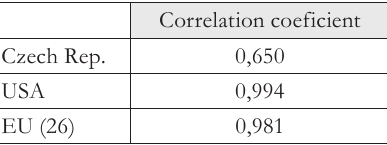
Tab. 3 - Correlation between number of tertiary education graduates and population. Source: (Eurostat, 2013a), own processing.